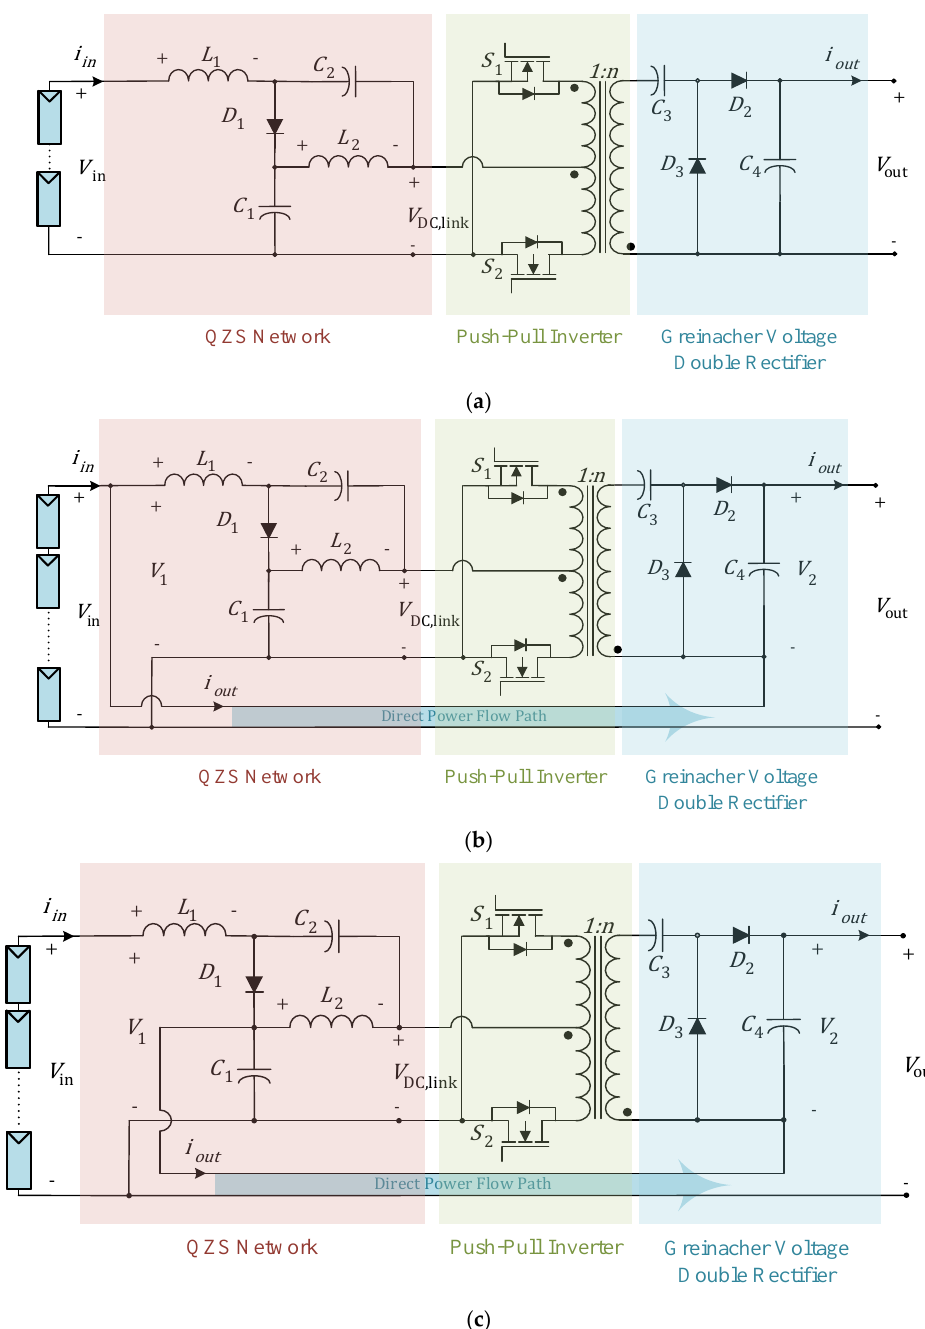
Figure 2. Equivalent circuits of the converters: ( a ) Full power quasi Z-source converter (QZSC), ( b ) Basic PPP QZSC, ( c ) Proposed PPP QZSC.